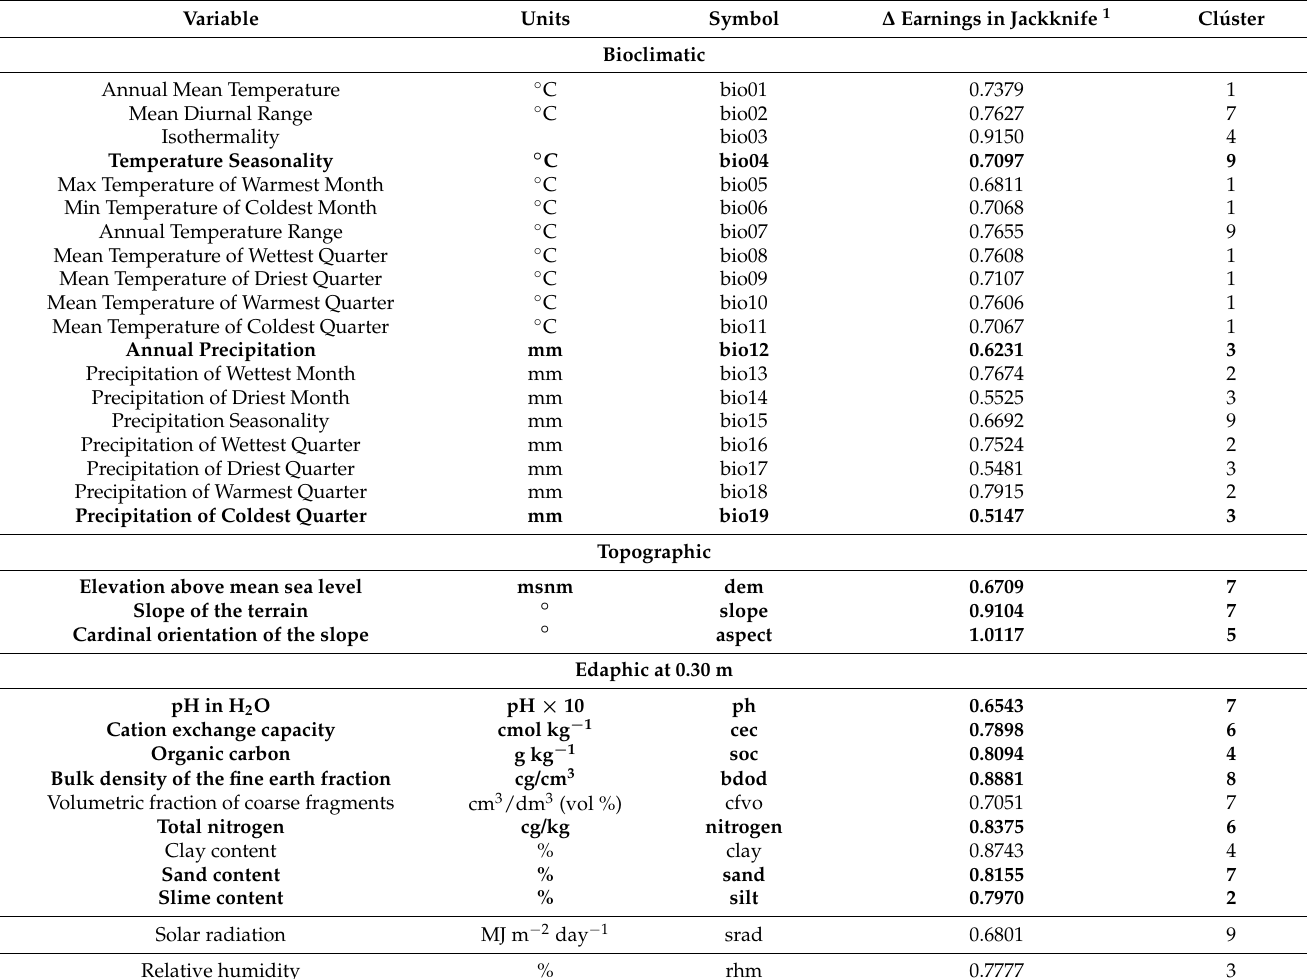
Table 2. Variables for MaxEnt modeling of Cedrela in